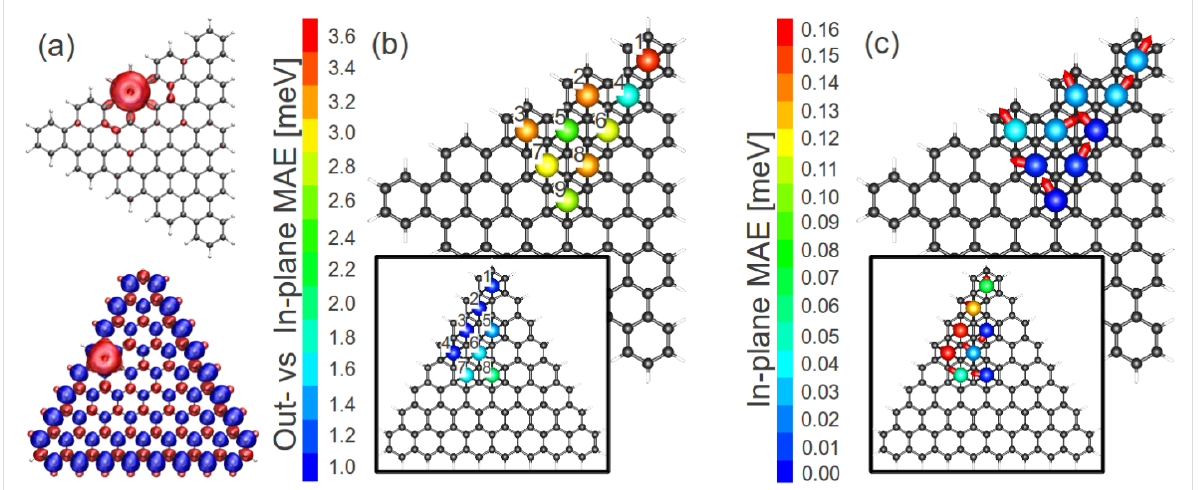
Figure 1: (a) The magnetization density of an armchair (top) and zigzag (bottom) graphene flake decorated with a single ruthenium adatom at a sep- aration of 1.75 Å from the flake plane; positive (negative) m (r) indicated by the red (blue) colour. Shown in panel (b) are the in-plane versus out-of- plane magnetic anisotropy energies for all symmetry-inequivalent adatom positions, see Equation 1 for the definition of this quantity, for both the armchair and zigzag (as inset) graphene flakes. In panel (c) are similarly presented the in-plane magnetic anisotropy energies (see Equation 2), with the red arrows indicating the direction of the minimum-energy in-plane position.